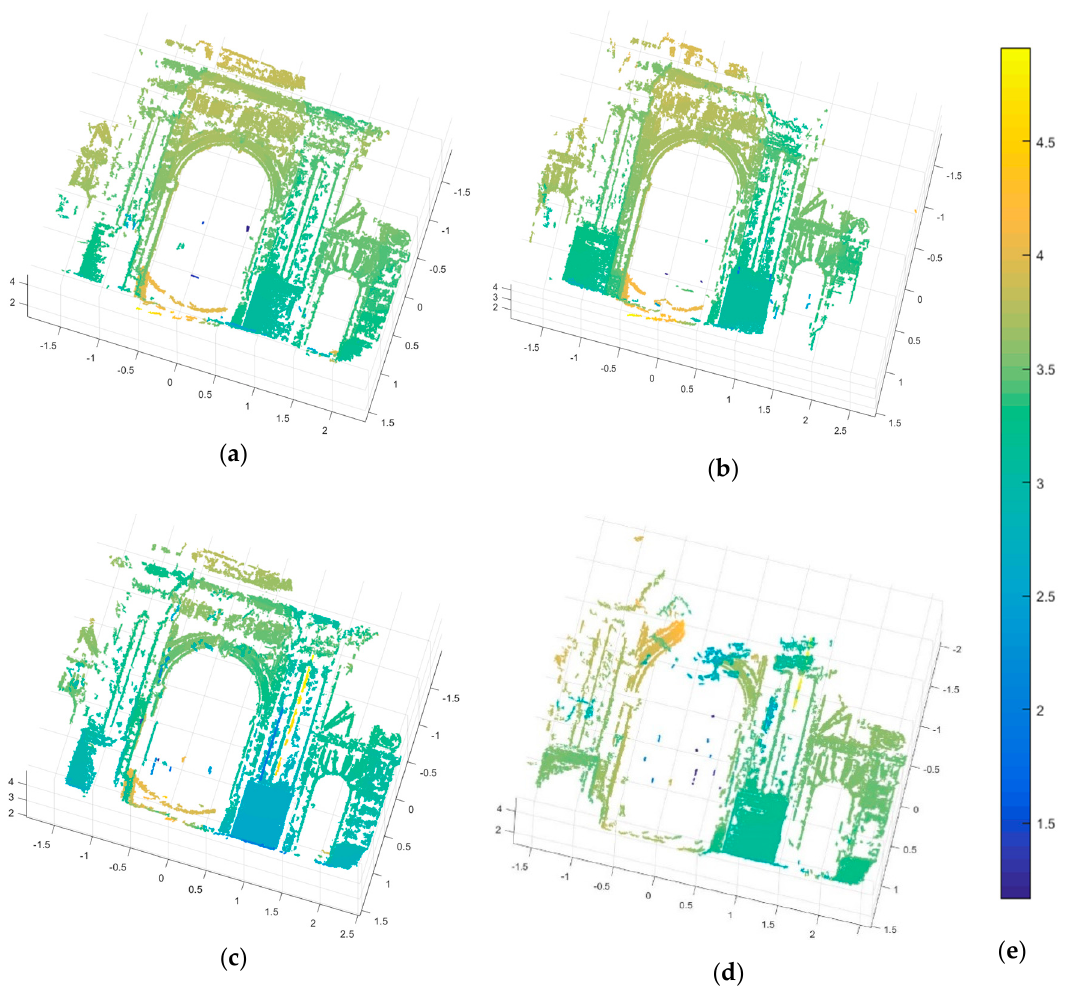
Figure 9. Dense point clouds. Reconstructed by matching points in ( a ) Figure 8a, ( b ) Figure 8b, ( c ) Figure 8c, and ( d ) Figure 8d. ( e ) Color bar. Different colors indicate the distance between the camera ( c ) Figure 8c, and ( d ) Figure 8d. ( e ) Color bar. Di ff erent colors indicate the distance between the camera and the reconstructed object. The unit of distance is meters. and the reconstructed object. The unit of distance is